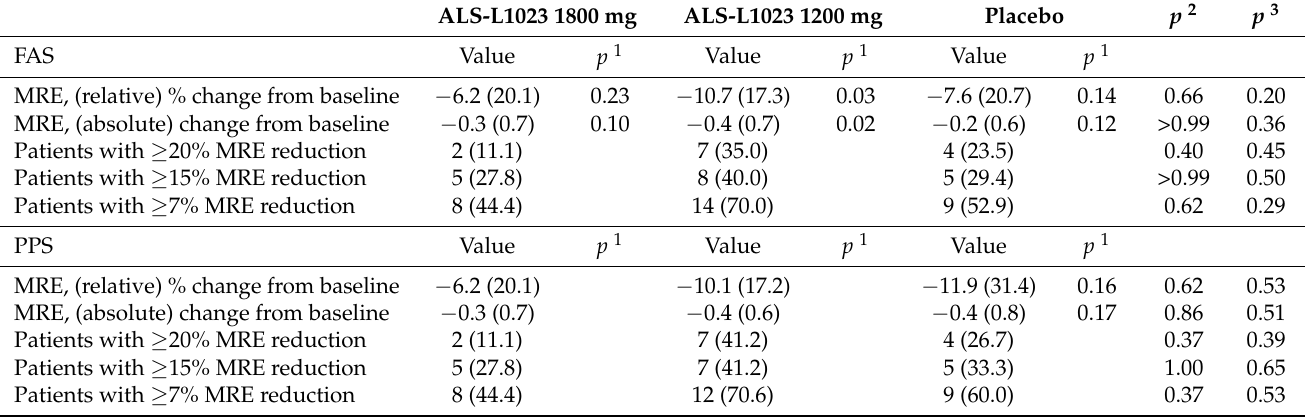
Table 3. Change in MRE from baseline to week 24. Table 4. Change in serum biomarkers from baseline to week 24 in the FAS.